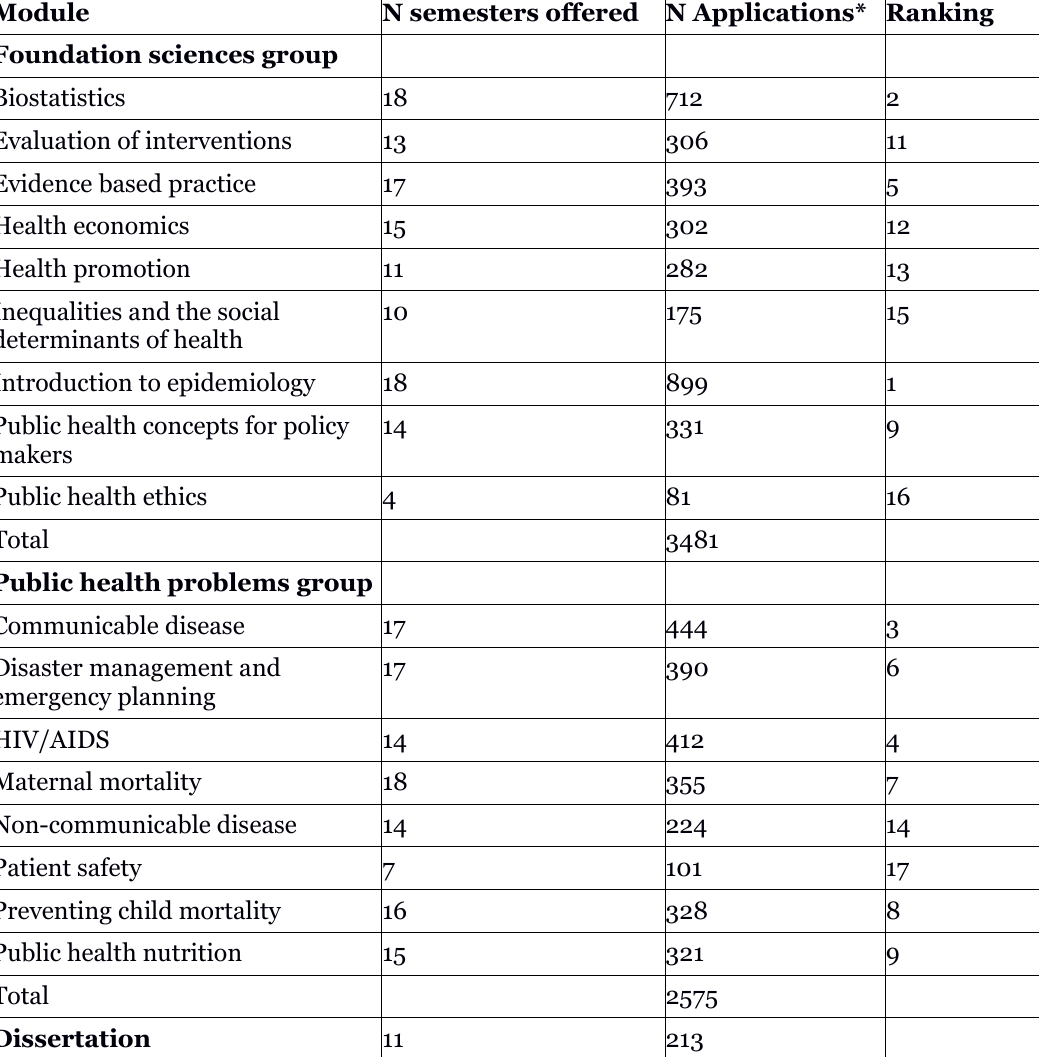
Table 4 Selection of Modules by